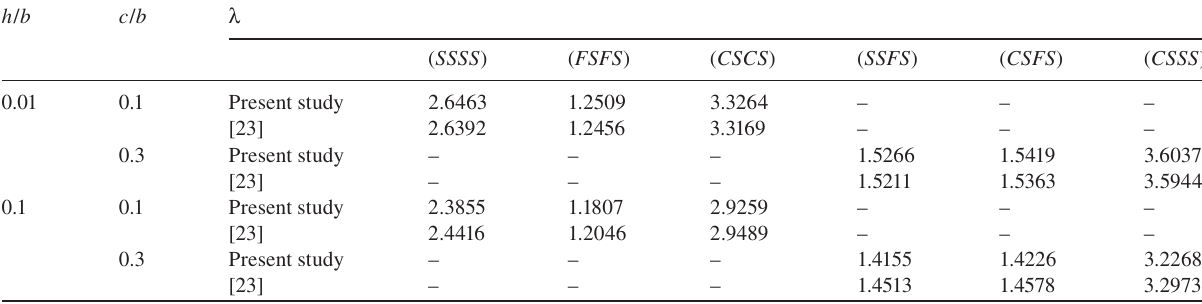
Table 1 Convergence study of square isotropic plates with an intermediate line support for different boundary